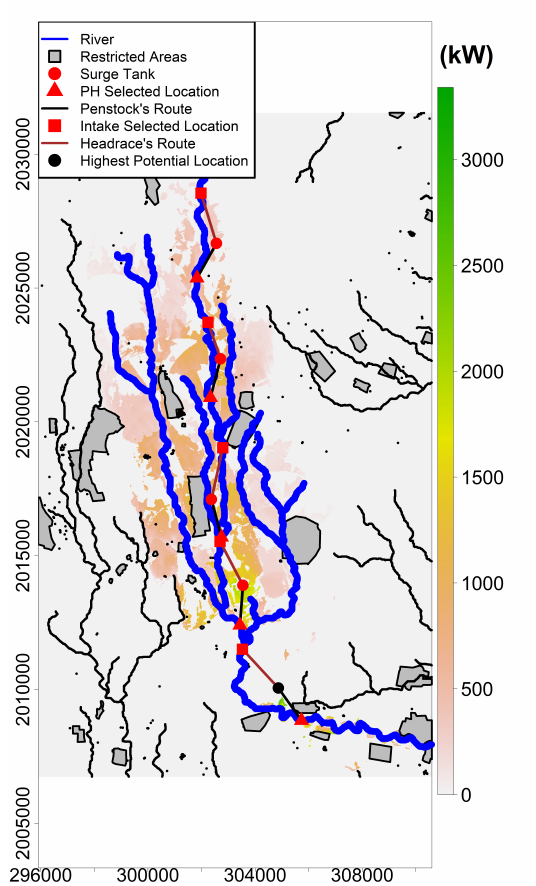
Figure 13. Hydropower map for R PH = 1500 m and R I = 2000 m, presenting 5 non-overlapping